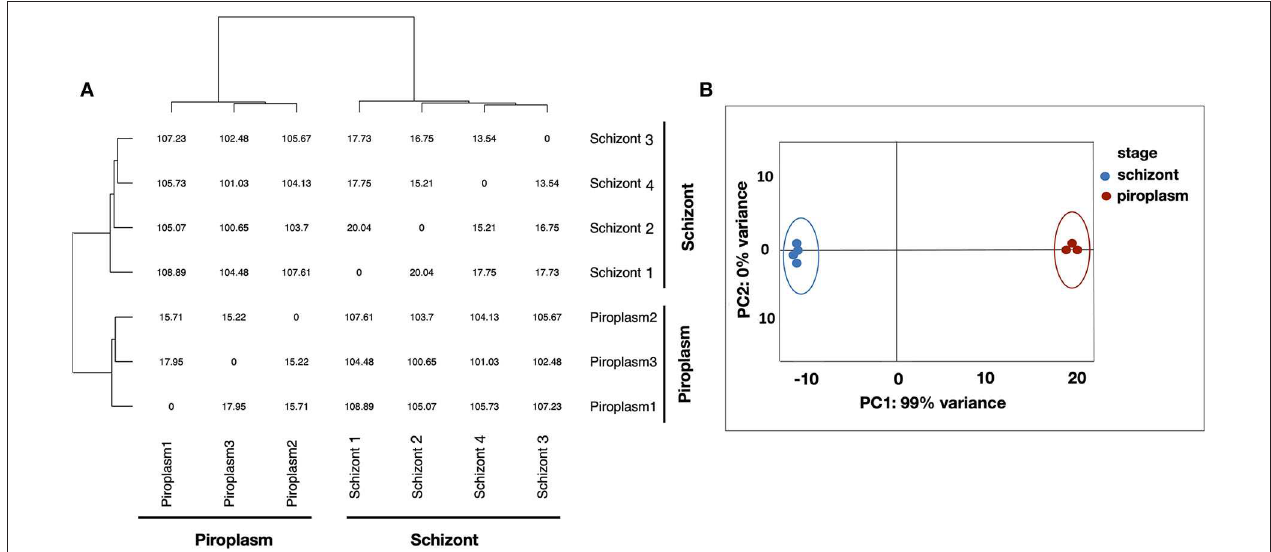
FIGURE 1 | Clustering analysis of samples. (A) Samples’ distance matrix of replicates clustering schizont and piroplasm replicates according to the life cycle stages. (B) Principal component analysis (PCA) of the replicates showing a variance of 99% between the schizont (blue) and piroplasm replicates (red).